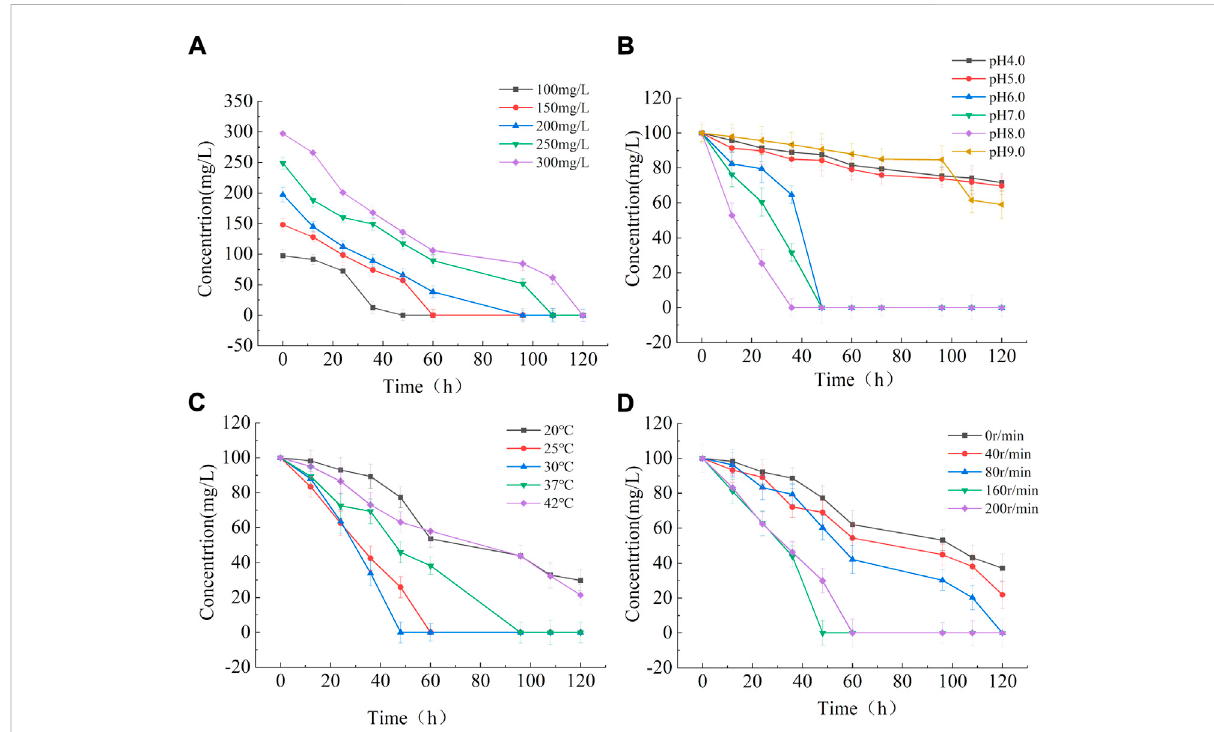
FIGURE 6 The impact of starting 3MI concentrations (A) , pH (B) , temperature (C) , and shaking speed (D) on 3MI